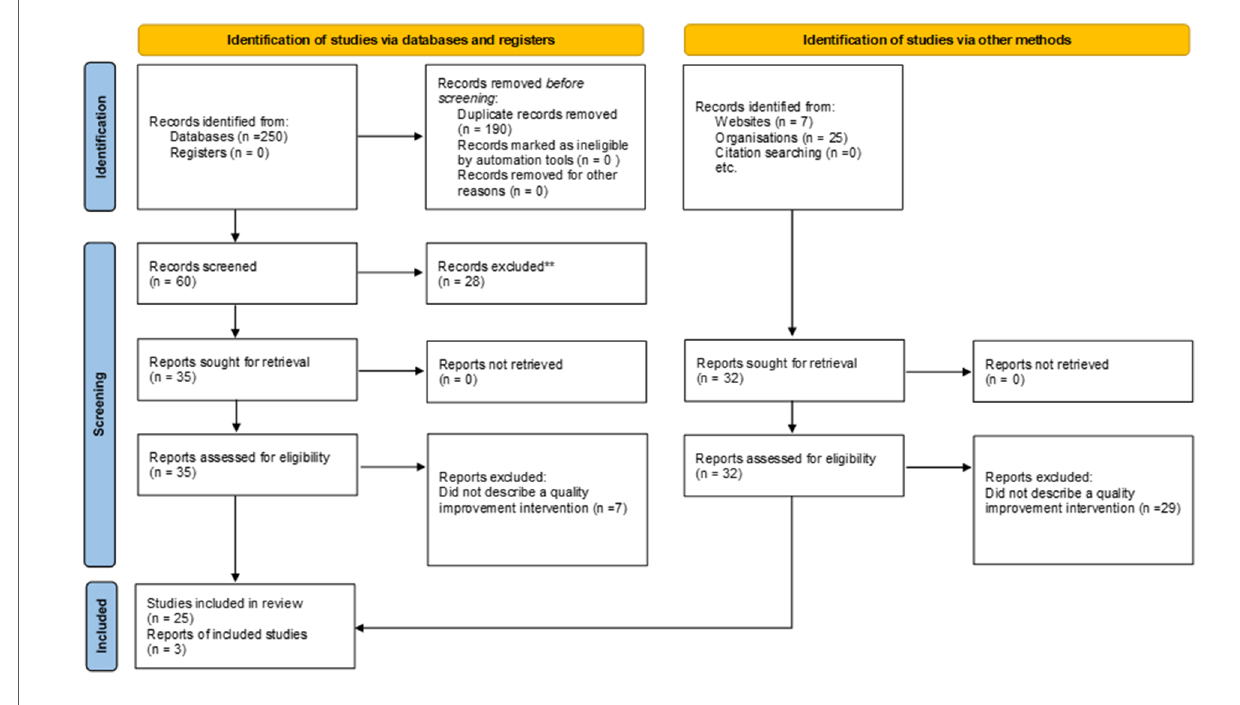
FIGURE 1 PRISMA fl ow chart [adapted from Page et al.